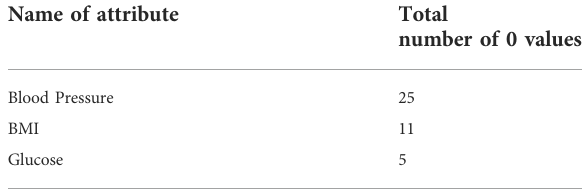
TABLE 2 Description of attributes in the PIMA Indian Diabetes dataset that have zero